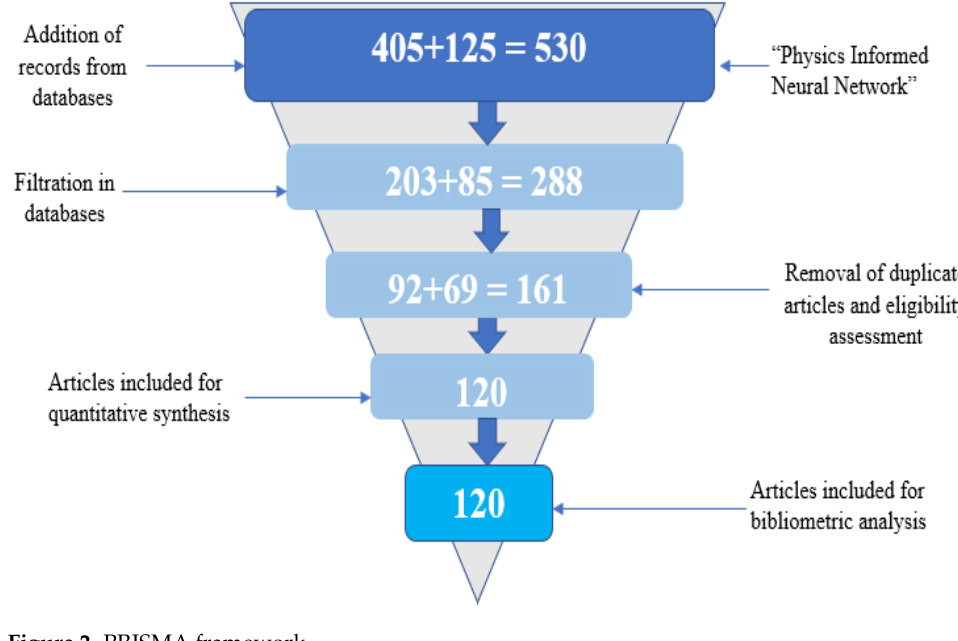
Figure 2. PRISMA framework. Duplicate articles were also removed from the Scopus and Web of Science metadata files. The two files were combined and duplicate journal articles removed. In this review, the PRISMA 2020 flow diagram was used, as shown in Figure 3 below.